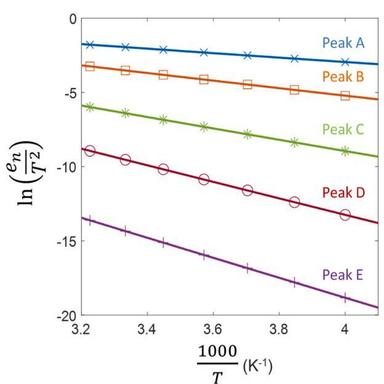
Fit of the "Arrhenius plots" from Ref. using our model.